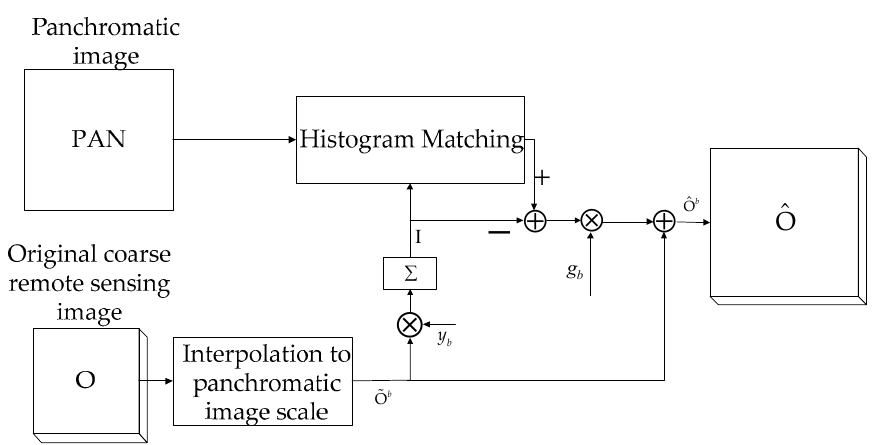
Figure 4. The flowchart of the principal component analysis (PCA) pansharpening.